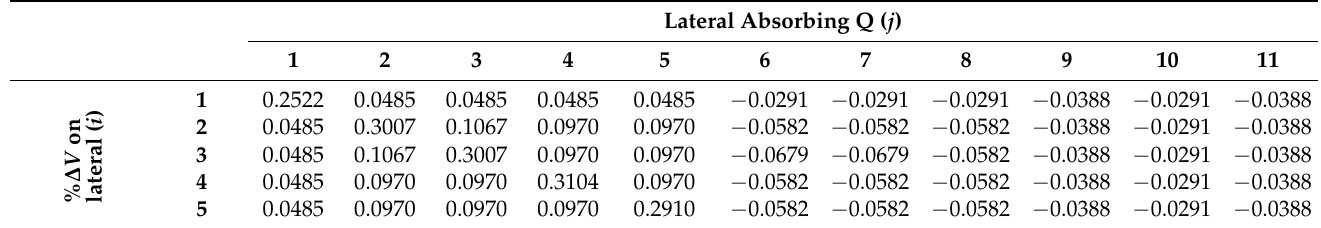
Table 4. Voltage sensitivity to change in reactive power (minimum change for three-phase laterals).